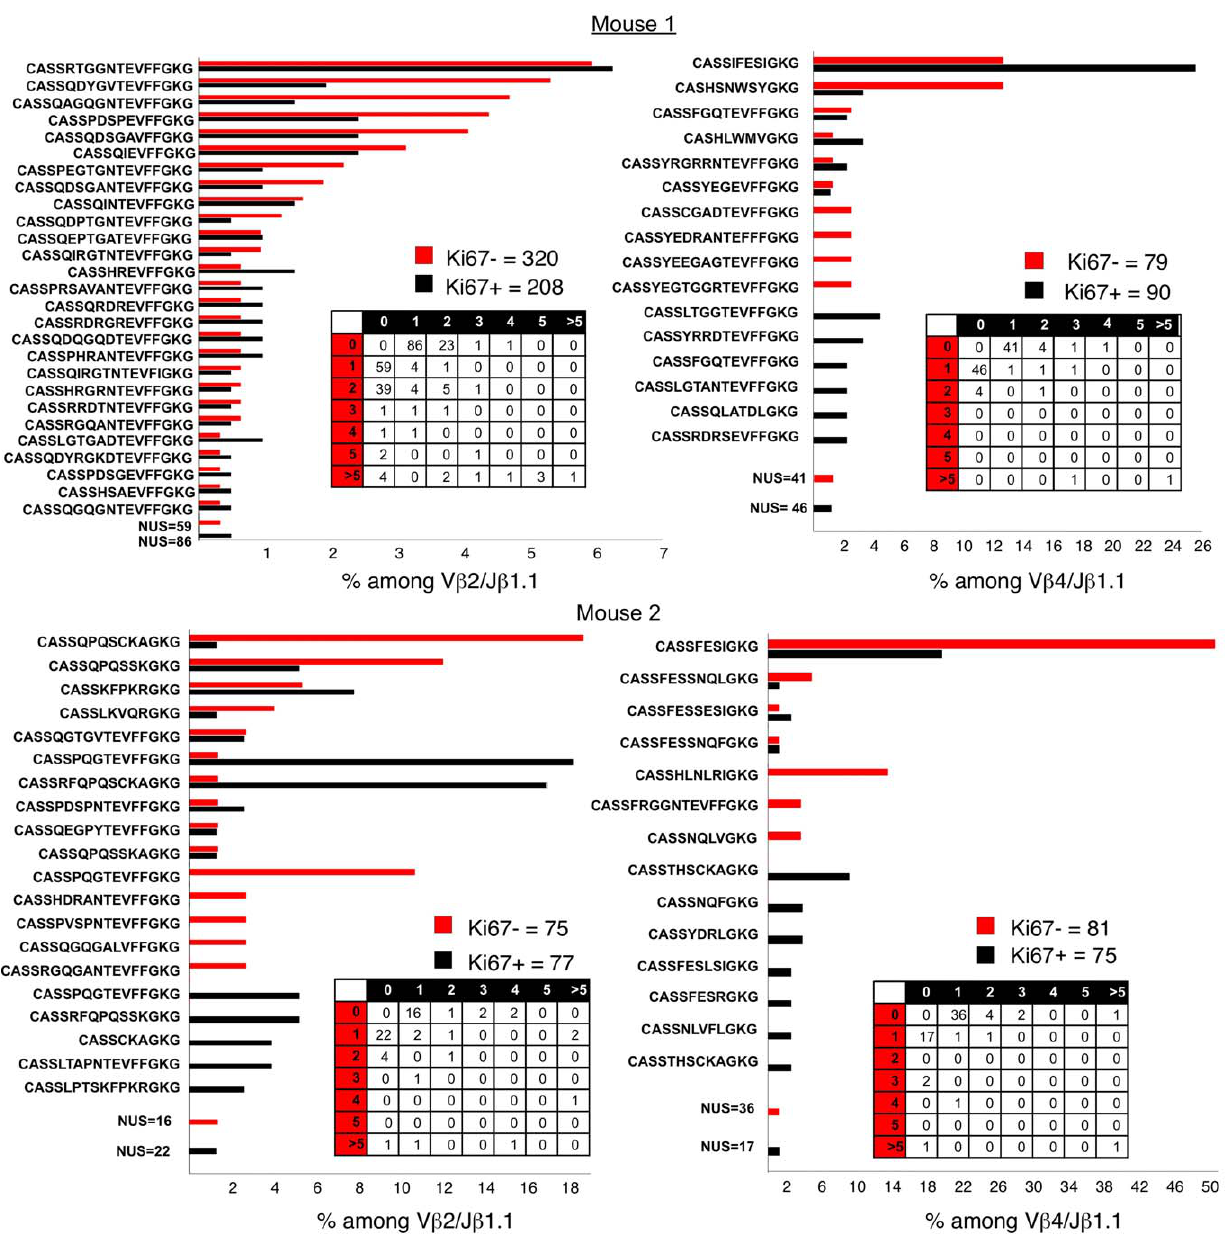
Figure 7. Sequence diversity among proliferating and nonproliferating V b 2-J b 1.1 and V b 4-J b 1.1 CD44 + , Foxp3 2 cells CD4 T cells (2). Sequence diversity within V b 2-J b 1.1 and V b 4-J b 1.1 Ki-67 bright and Ki-67 negative CD44 + CD4 T-cell populations. Shown is the percentage occurrence of a given sequence in two mice. N is indicated above each table for Ki-67 bright and Ki-67 negative cells. NUS indicates number of unique sequences that occur only once in either the Ki-67 bright and Ki-67 negative cells. Each table represents the numbers of sequences that occur once, twice, three times, four times, five times, and more than five times among the Ki-67 bright and Ki-67 negative populations.